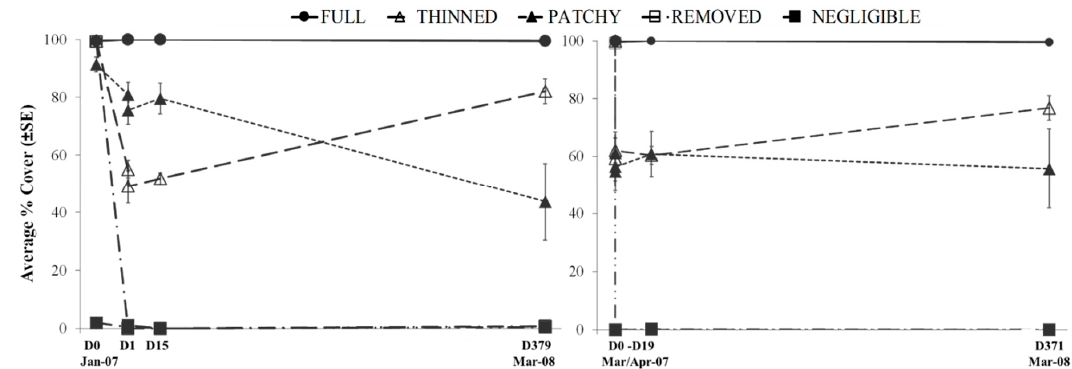
Figure 4. Average ± SE percentage cover of Hormosira banksii canopy over time and between treatments at 13th Beach (left) and Bridgewater Bay (right). N = 5 for all treatments.